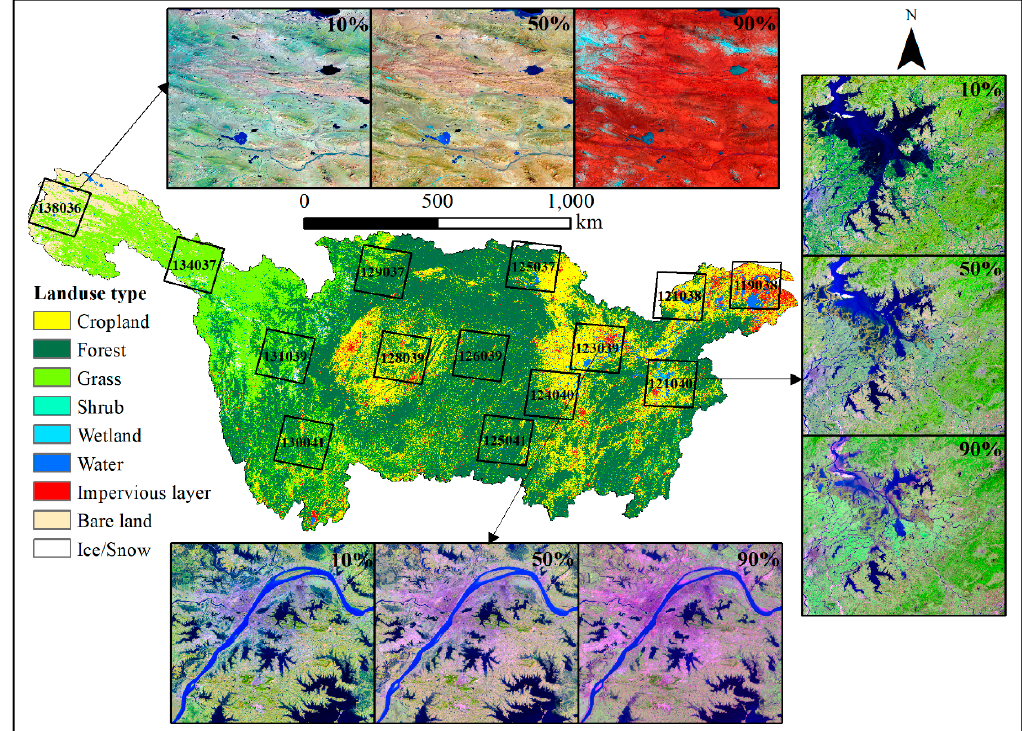
Figure 3. The spatial distribution of sampling plots and 10%, 50%, and 90% percentile composite images for three sampling plots. The number in sampling plots indicates the Landsat path (the first three digits) and row (The last three